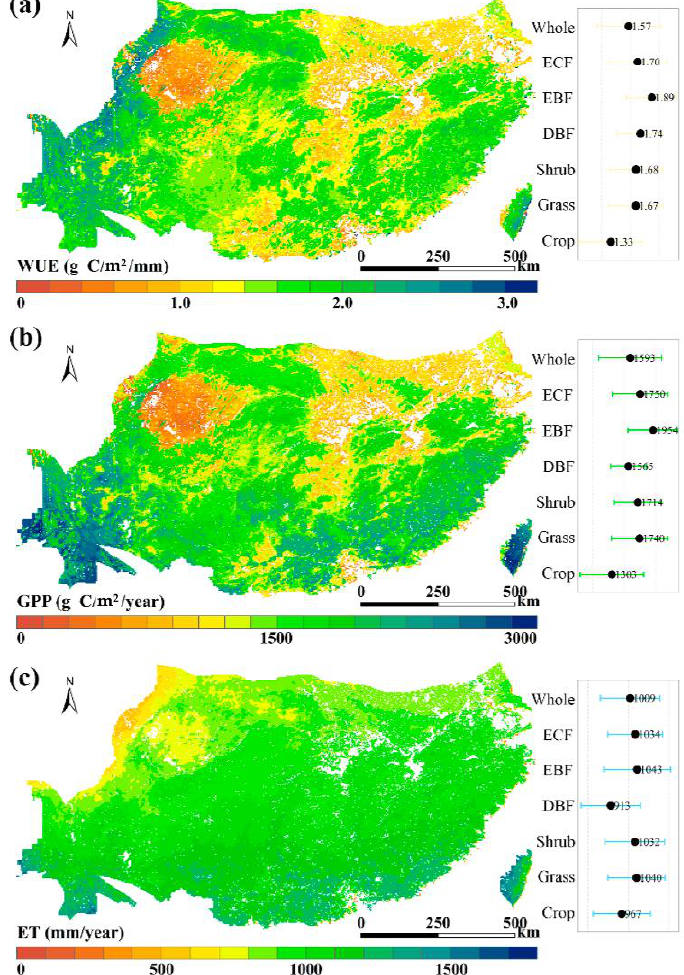
Figure 1. Spatial patterns of ( a ) mean annual water use efficiency (WUE), ( b ) Gross Primary Produc- tivity (GPP), and ( c ) evapotranspiration (ET) in subtropical China. The right insets indicate the mean annual WUE, GPP, and ET of different landscapes, with whiskers indicating the standard deviations of all grid cell values. Other abbreviations: ECF, evergreen coniferous forest; EBF, evergreen broadleaf forest; DBF, deciduous broadleaf forest.